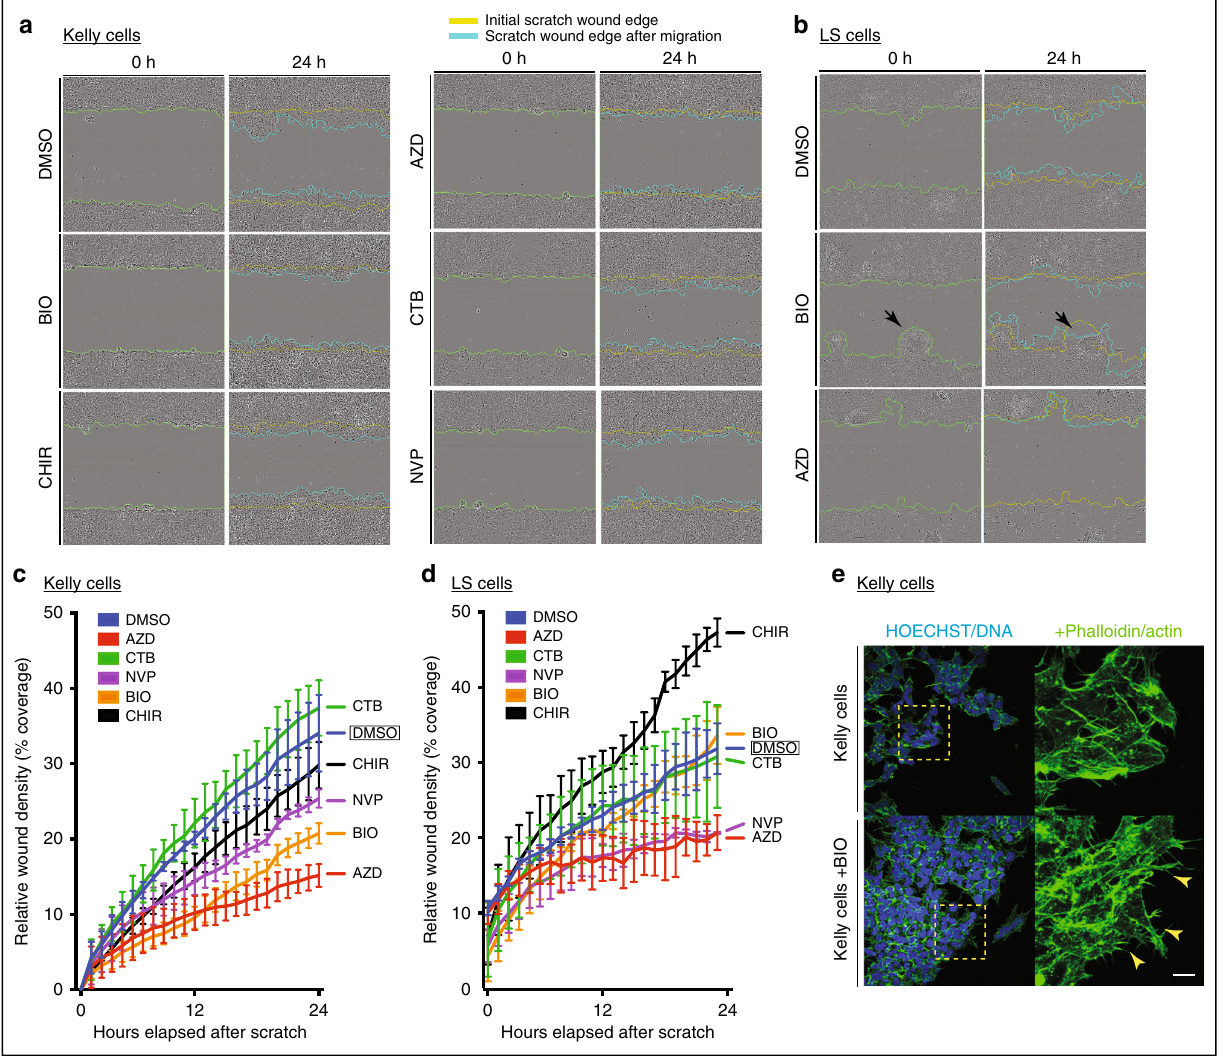
Fig. 8 GSK3 and ALK inhibition affect migration in neuroblastoma cell lines. a , c Cell migration assay for Kelly neuroblastoma cell line. a Representative bright- fi eld still images at start ( t = 0 h) and end ( t = 24 h) time points of the migration assay in Kelly cells under various GSK3 (0.5 μ M BIO, 1.0 μ M CHIR99021) and ALK inhibition treatments (1.5 μ M CTB, 1.5 μ M AZD-3463 and 1.0 μ M NVP-TAE684). c Line graph representing the percentage of wound coverage over time. Notice that upon NVP-TAE684 (NVP) and BIO treatments cells do not close the wound as quickly as the control or unaffected CTB samples. AZD treatment showed the lowest percentage of wound coverage. b , d Cell migration assay for LS neuroblastoma cell line. b Representative bright- fi eld still images at start ( t = 0 h) and end time ( t = 24 h) points of the migration assay in LS cells under GSK3 inhibition (0.5 μ M BIO) and ALK inhibition treatment (1.5 μ M AZD-3463). Note that upon BIO treatment LS cells tend to aggregate and expand into the wound (black arrows). d Line graph representing the percentage of wound coverage in LS cells. There is a tendency to increase migration upon GSK3 inhibition (BIO and CHIR). The lower wound coverage upon ALK inhibition treatment correlates with reduced population of cells at the end of the assay suggesting a compromise in cell viability under these conditions. e Representative images of actin staining (phalloidin, green) showing Kelly cells treated with BIO compared to controls. Notice the irregular spiky protrusions of cells where GSK3 is inhibited (yellow arrowheads). Scale bar, 25 μ NB cell lines used are noted in Supplementary Table 2 and Supplementary substrate (ECL) (Immobilon, Millipore) and ChemiDoc TM Touch Imaging System References. All cell lines were mycoplasma tested. (BioRad) for detection. Densitometry was performed using the Fiji-ImageJ analysis software, and all the values were normalized to HSP-90 or GAPDH controls per standard approaches. Uncropped blots can be found in Supplementary Figures 7 – 9. Antibodies . For the list of primary and secondary antibodies used for immuno- fl uorescence and western blotting, please refer to Supplementary Table 3. Embryo fi xation and histology . Mouse embryos at e10.5 were collected in cold PBS and fi xed overnight in 4% paraformaldehyde at 4°C. Mouse embryos at e8.5, Immunoblotting . Cells were washed twice with phosphate-buffered saline (PBS) e8.75 or e9.5 were collected in cold PBS and fi xed in 4% paraformaldehyde for 2h and lysed with RIPA lysis buffer with added phosphatase inhibitor (PhosStop, at 4°C. Roche) and protease inhibitor (cOmplete TM , Roche). Protein concentrations were Samples were subsequently washed in PBS three times at room temperature (RT) for 10 min each time, then treated as corresponding subsequent method. For determined by Bradford protein assay (BioRad). Proteins were resolved by sodium sections, samples were cryoprotected by incubating at 4°C overnight in graded dodecyl sulfate-polyacrylamide gel electrophoresis on 4 – 12% precast gels (NuPA- sucrose solutions in PBS. Tissues were then embedded in Optimal Cutting GE ® Bis-Tris), then transferred to polyvinylidene di fl uoride membrane Temperature and frozen at − 20°C. Heads and bodies were sectioned at 10 μ m and (IPVH00010, Millipore) using Trans-Blot ® SD semi-dry transfer cell (BioRad). frozen at − 20 °C after drying at RT for 1h. For whole mount mRNA in situ Immunoblots were developed using chemiluminescent horseradish peroxidase